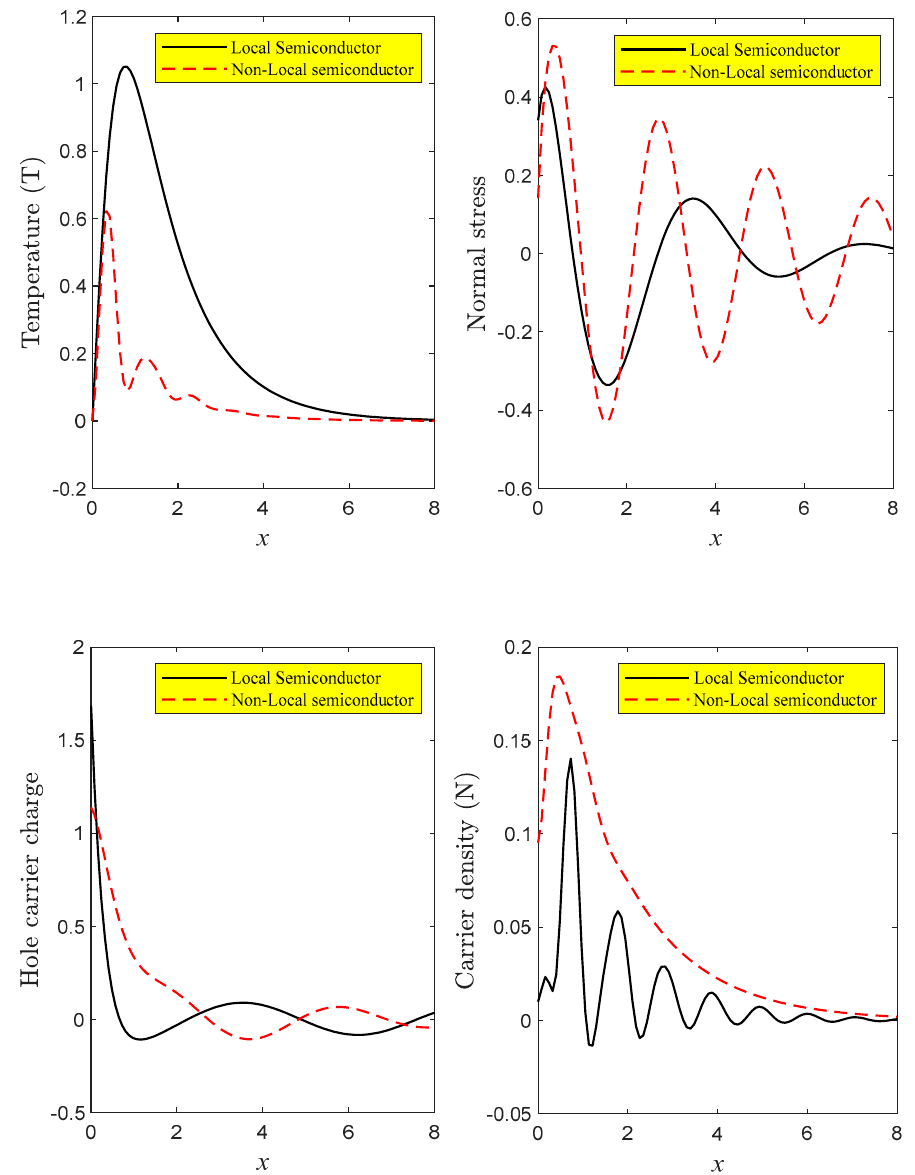
Figure 3. According to the DPL model with the influence of Hall current, the primary field distribu- tions against distance change in both the presence and absence of the non-local